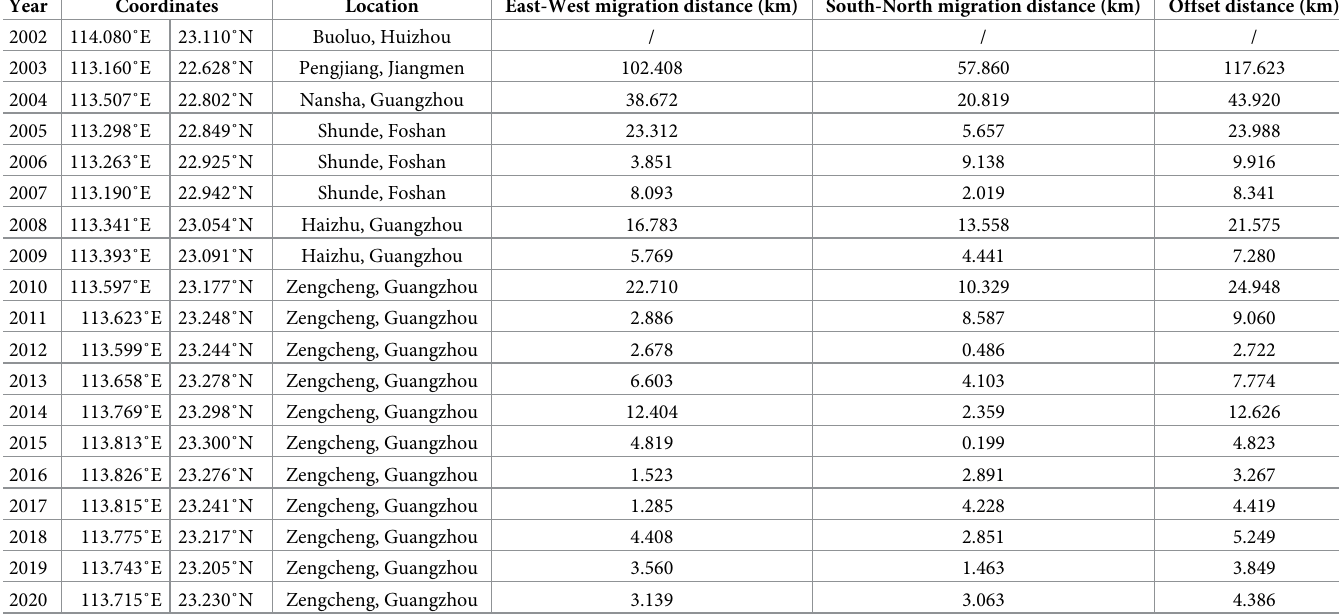
Table 3. Center of gravity parameter for the spatial distribution of A-level scenic spots in Guangdong